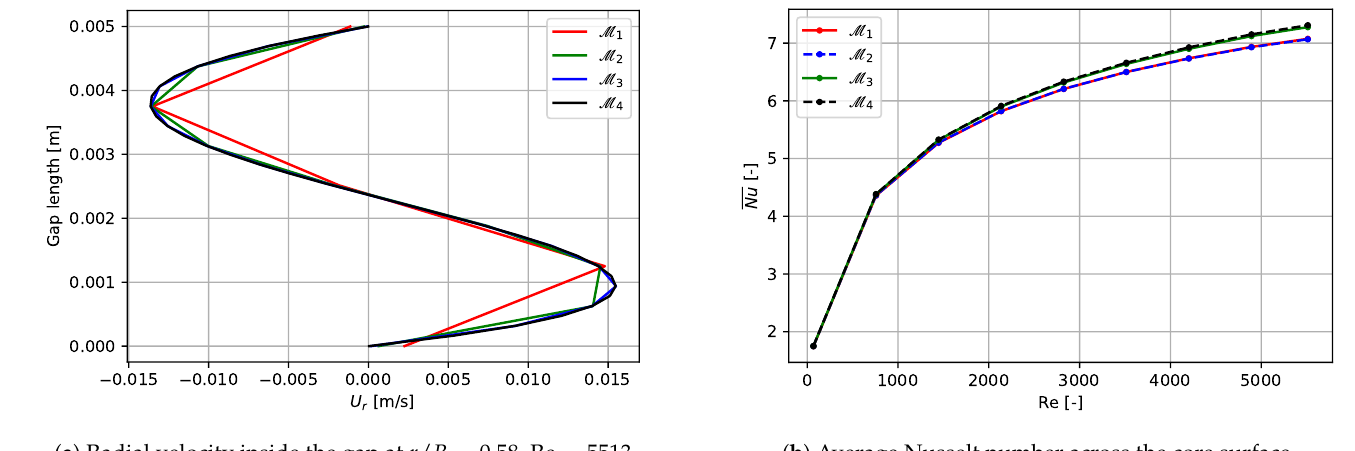
( a ) Radial velocity inside the gap at r / R = 0.58, Re = 5513 Figure 13. Convergence study of the main quantities of interest, viz. , the radial velocity and average Nusselt number. Mesh sizes range from M 1 = 82,252 to M 4 = 217,914 degrees of freedom.